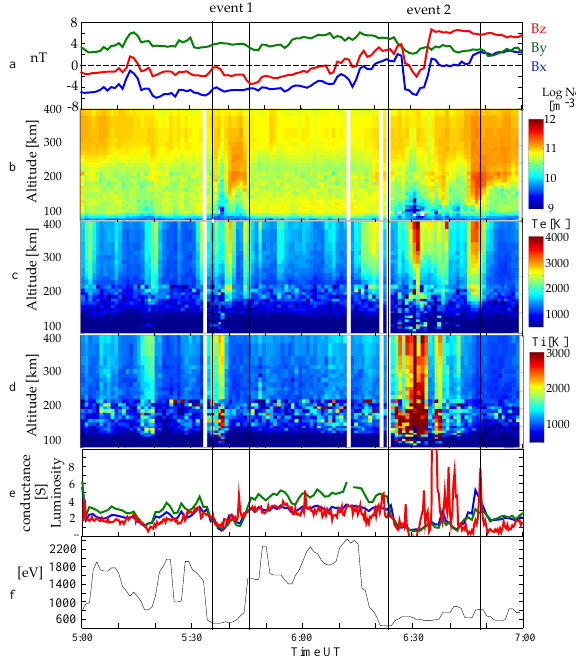
Fig. 3. (a) IMP-8 Interplanetary magnetic field data, (b) , (c) and (d) EISCAT Svalbard radar (ESR) electron density [ m − 3 ] , electron and ion temperature estimates [ K ] (e) Hall (green line) and Pedersen (blue) conductances [ S ] calculated from ESR and corresponding line-of-sight integrated luminosity (arbitrary scale, red line) from the FMI Longyearbyen all-sky camera, (f) average energy of pre- cipitating electrons [ eV ] derived from EISCAT ionization